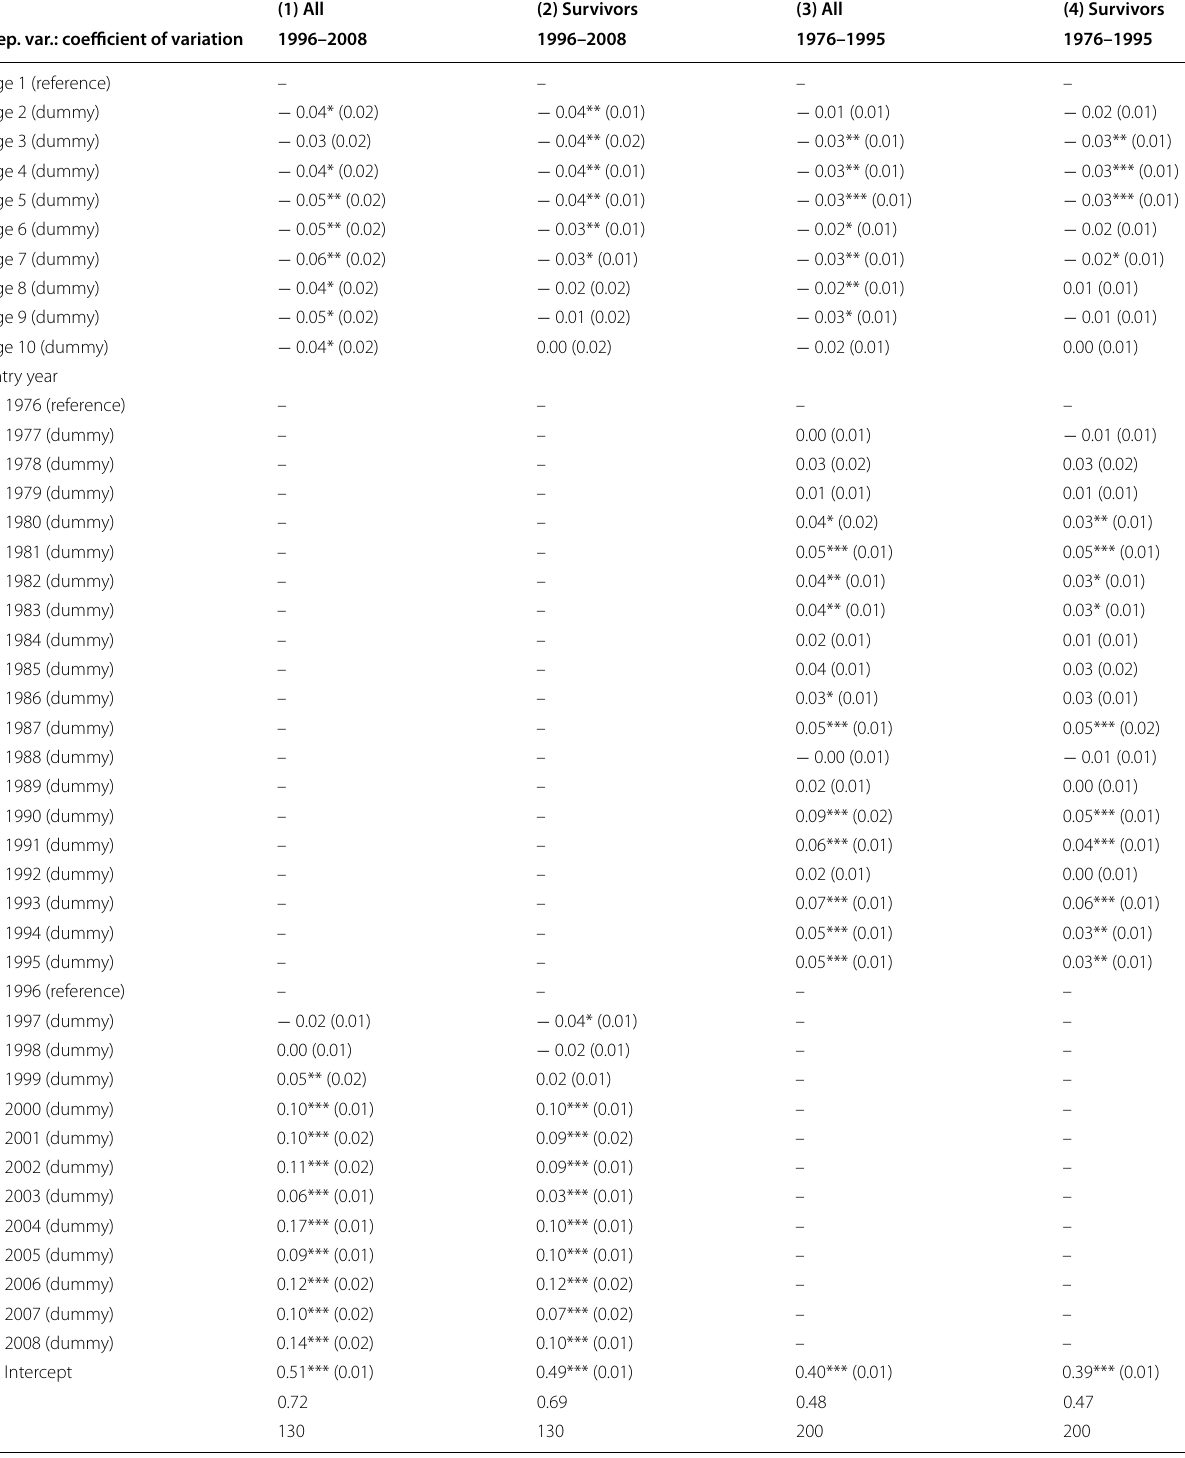
West Germany, manufacturing sector. 1976–2008, OLS estimations with the coefficient of variation (sd/mean) as a dependent variable in all specifications. Robust standard errors in parentheses. */**/*** indicates statistical significance at the 10/5/1 percent level. Age-cohort cells weighted with number of establishments per cell. Number of establishments per cell vary between 1176 and 2345 (mean 1678) in columns (2) and (4) and between 1269 and 5093 (mean 2498) in columns (1) and